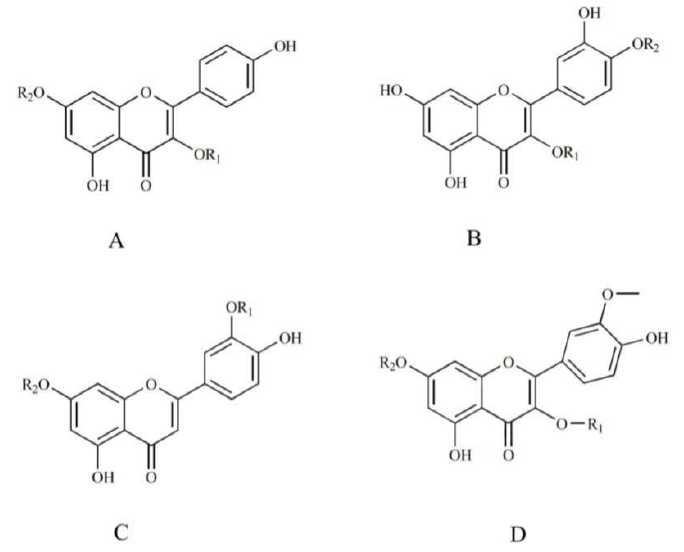
Figure 5. The flavonoid skeletons identified from different parts of PPL in positive ion mode. ( A ) Kaempferol-type; ( B ). quercetin-type; ( C ) luteolin-type; ( D ) isorhamnetin−type.